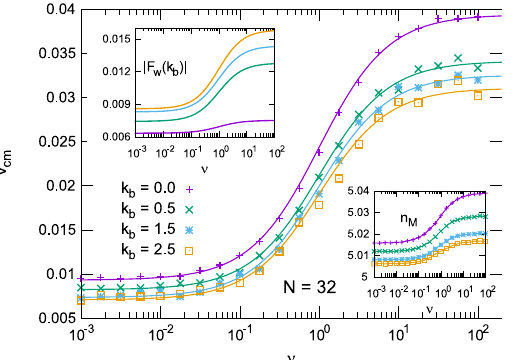
Figure 3. Mean velocity of the polymer center of mass with N = 32 for different values of the bending k b = 0.0, 0.5, 1.5, 2.5. Symbols stand for numerical simulations, full lines show the MM best fit according to Eq. (9). The right inset shows the corresponding mean number of monomers inside the motor n M during the simulations. Left inset: absolute value of the mean reaction force exerted by the walls during the translocation as a function of the motor actuation rate ν